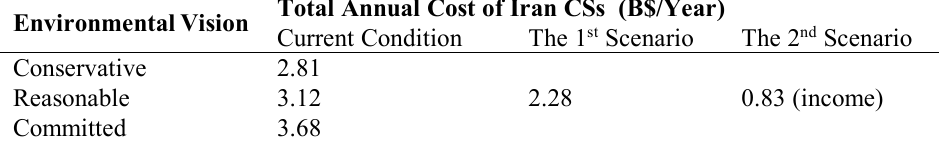
Table 19 . Economic impact of replacing all CSs power demand with geothermal